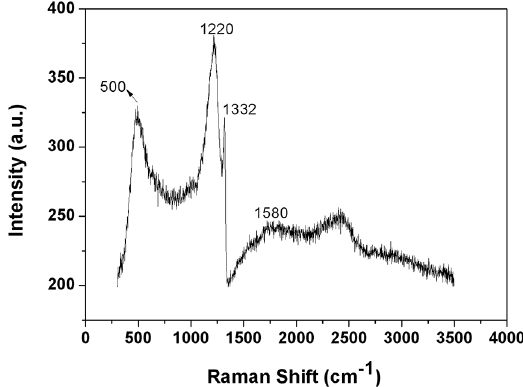
Figure 2. Raman spectra of diamond films grown on titanium substrates with 15000 ppm